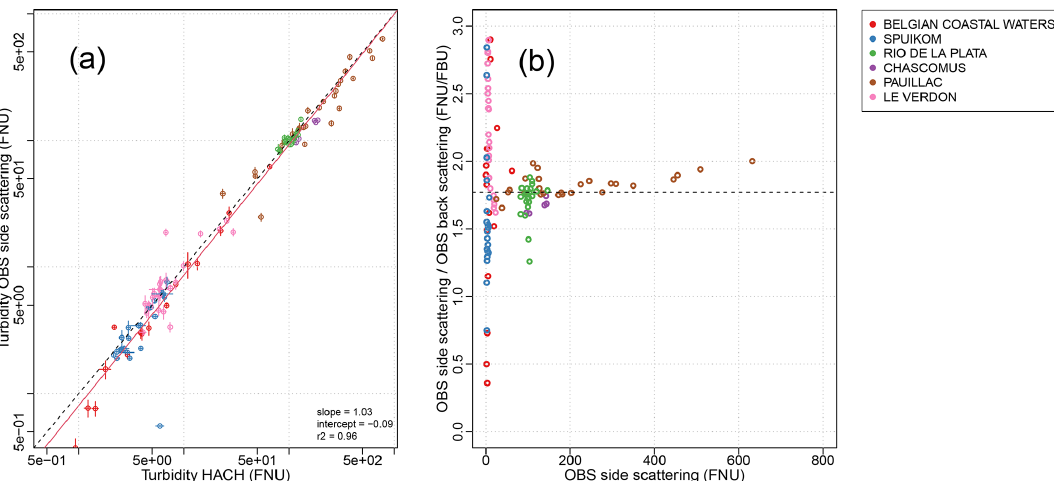
Figure 4. Turbidity measured by HACH instrument as a function of side-scattering turbidity measured by the OBS instrument (a) . The red line shows the least squares regression between these variables. (b) Ratio of the OBS side-scattering to backscattering ratio as a function of the OBS side-scattering. The horizontal dotted line represents the median value of the scattering